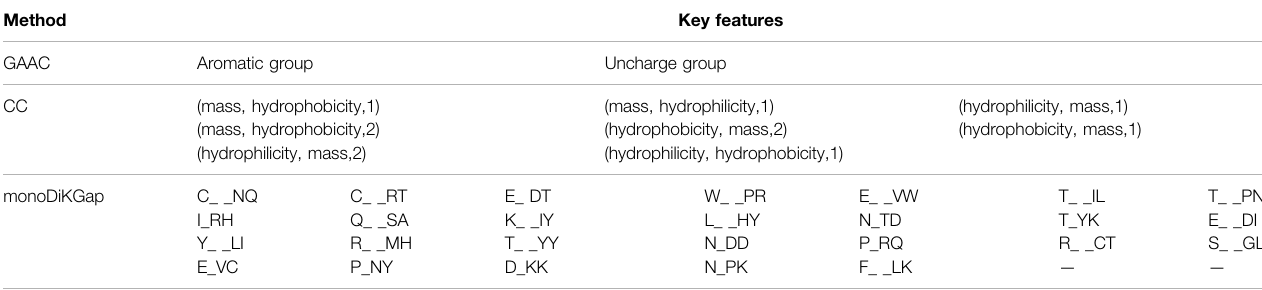
TABLE 7 | Key feature details of each feature representation method.